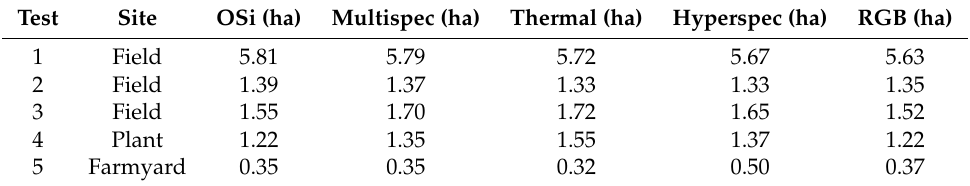
Table 3. Validation of area calculation from the sensor pod—OSi orthophotography used to calculate reference